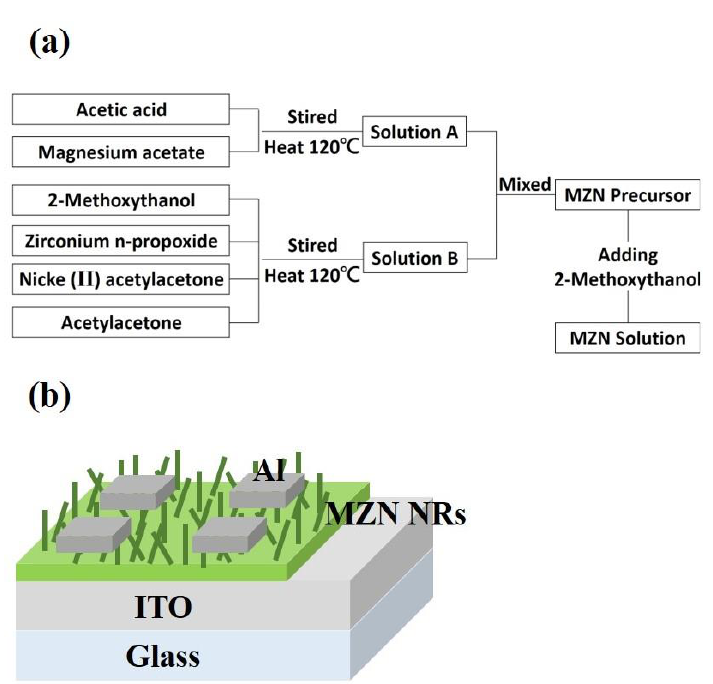
Figure 14. ( a ) Flow chart for preparation of 0.5 M MZN solution; and ( b ) schematic of Al/MZN NR/ITO device and set up for measurement.